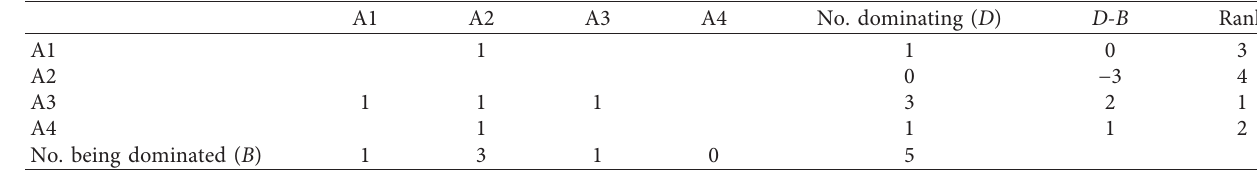
Table 10: Dominant matrix of actors with respect to processes.